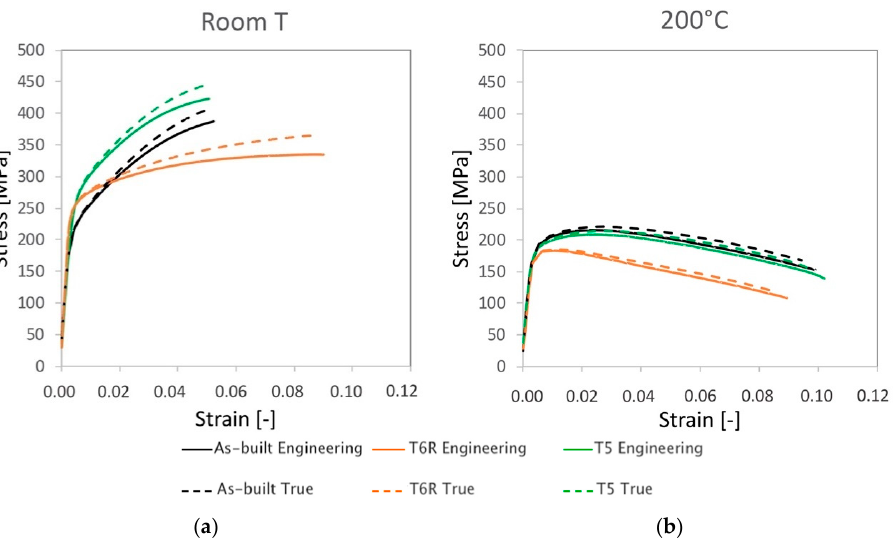
Figure 3. Representative engineering and true stress-strain curves for the as-built, T5, and T6R AlSi7Mg PBF-LB alloy: ( a ) room temperature and ( b ) high temperature (200 °C) tensile tests.